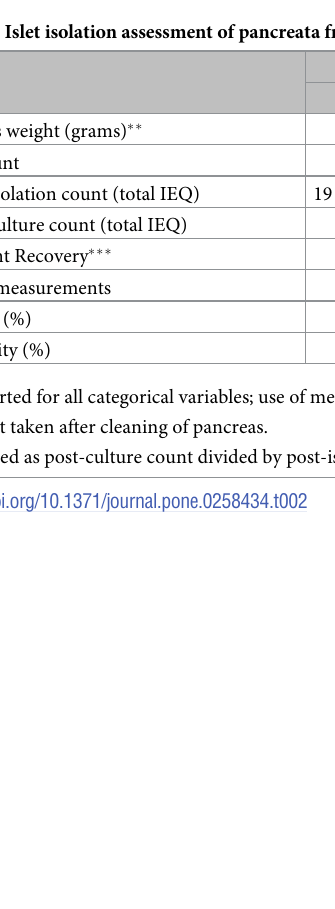
To evaluate the islet function in vivo , isolated human islets were transplanted into diabetic NOD SCID mice. Animals transplanted with islets from chronic marijuana-users showed